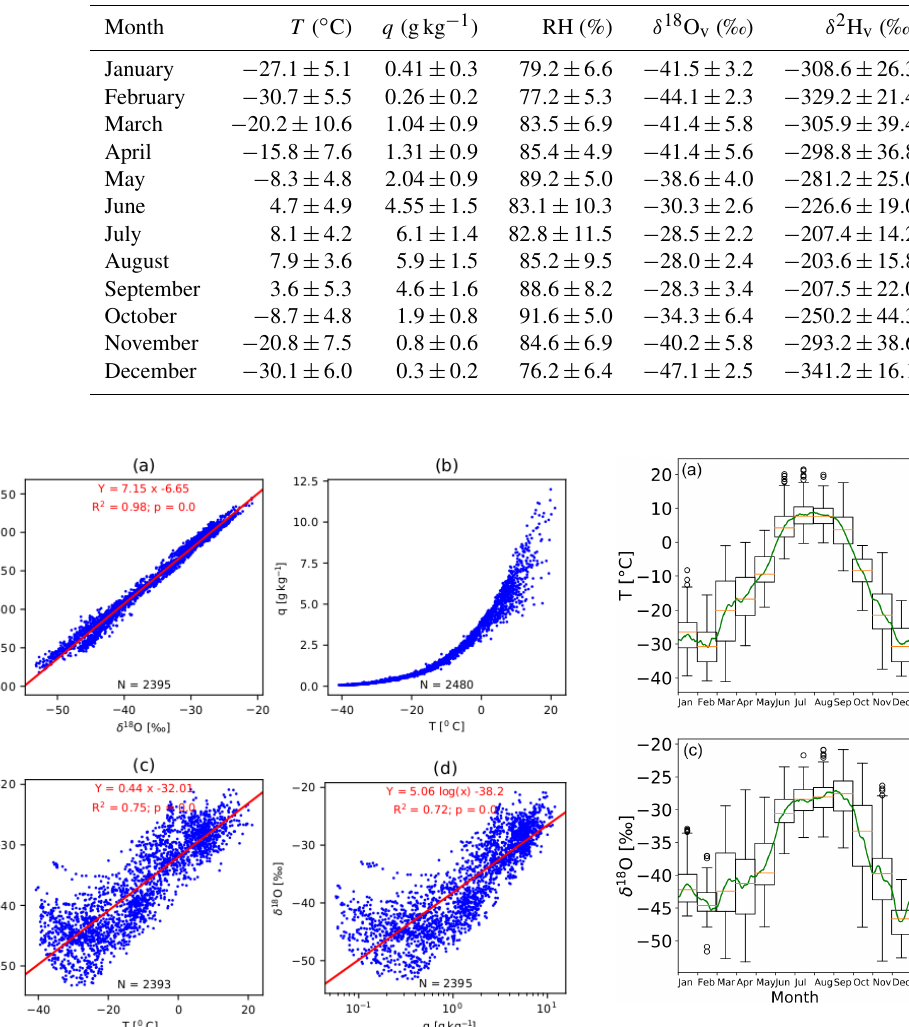
Figure 4. Average seasonal cycle for the period 1 July 2015 to 1 July 2017 for (a) air temperature ( ◦ C), (b) specific humidity q (gkg − 1 ), (c) δ 18 O v (‰) and (d) d -excess v (‰). For box plots, the boxes represent the first and third quartiles, and the orange bar rep- resents the median; the whiskers represent the lowest (highest) da- tum still within the 1.5 interquartile range (IQR) of the lower (up- per) quartile, and the outliers are represented as black